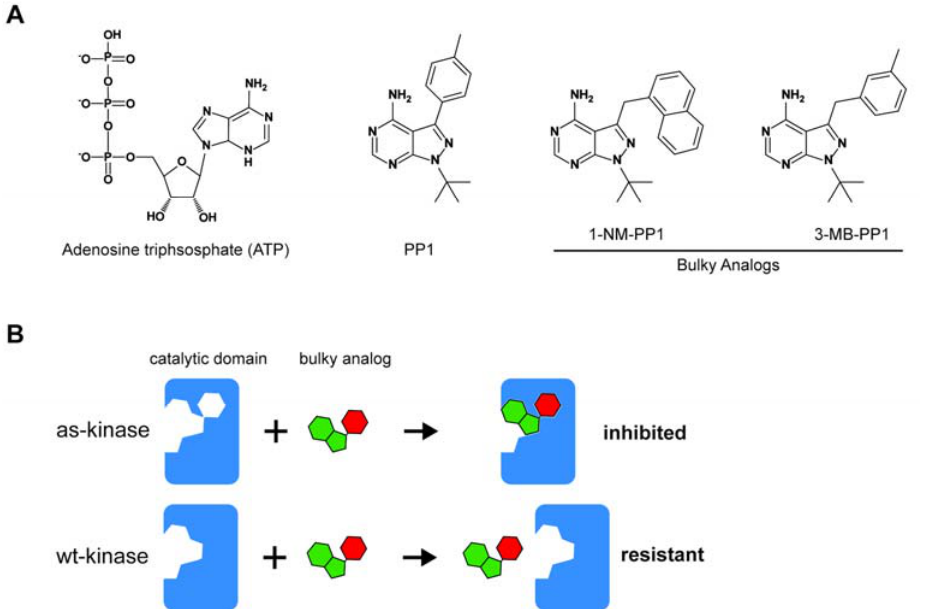
Figure 1. Chemical-genetic strategy for specific kinase inhibition. ( A ) Chemical structures of Adenosine triphosphate (ATP), the Src inhibitor PP1, and its bulky analogs, 1-NM-PP1 and 3-MB-PP1; ( B ) An enlarged ATP-binding pocket in the catalytic domain of the analog sensitive kinase (as-kinase) accommodates the analog, inhibiting activity, whereas the non-enlarged pocket of the wildtype kinase (wt-kinase) is